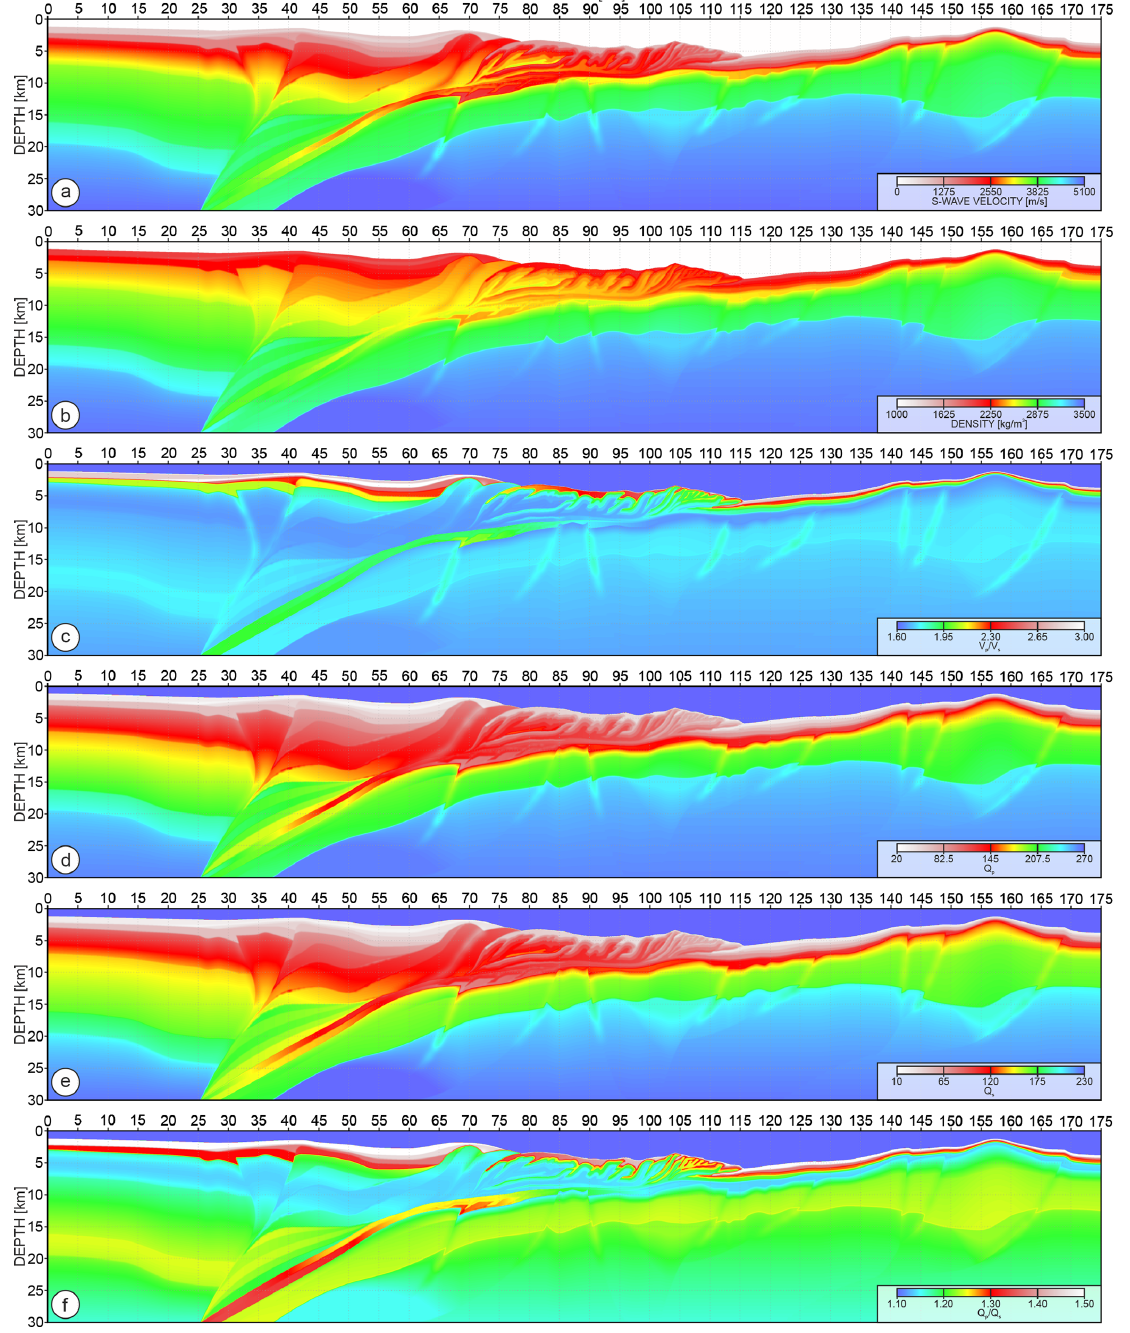
Figure 6. (a) V s , (b) ρ , (c) V p /V s , (d) Q p , (e) Q s , (f) Q p /Q s models derived from the V p inline from Fig. 4c.